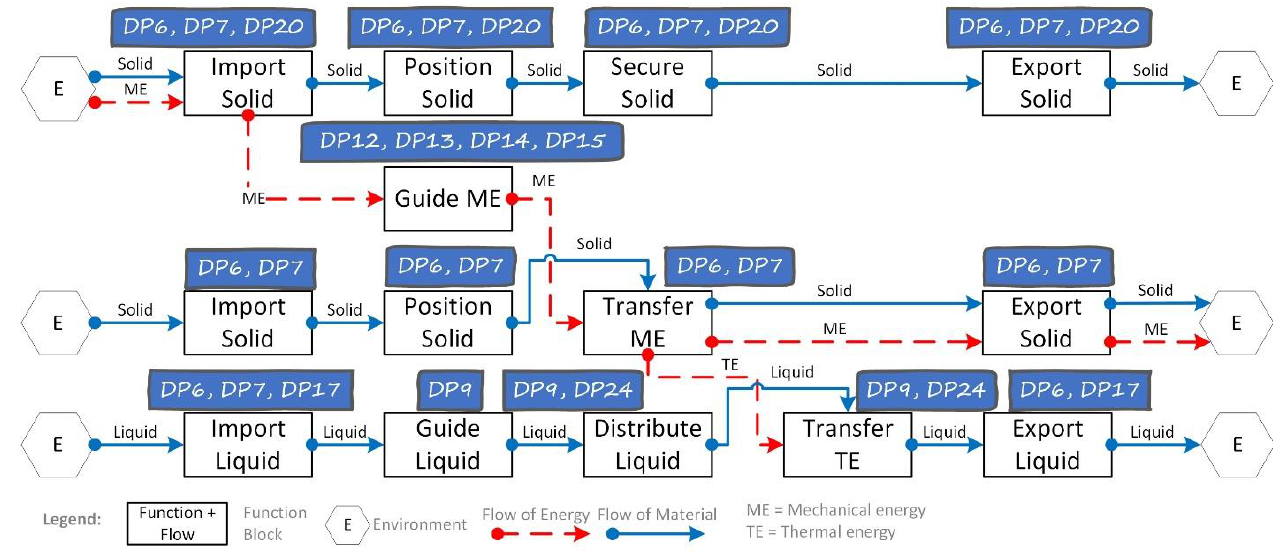
Figure 6. Function structure of a gear with mapped DPs.